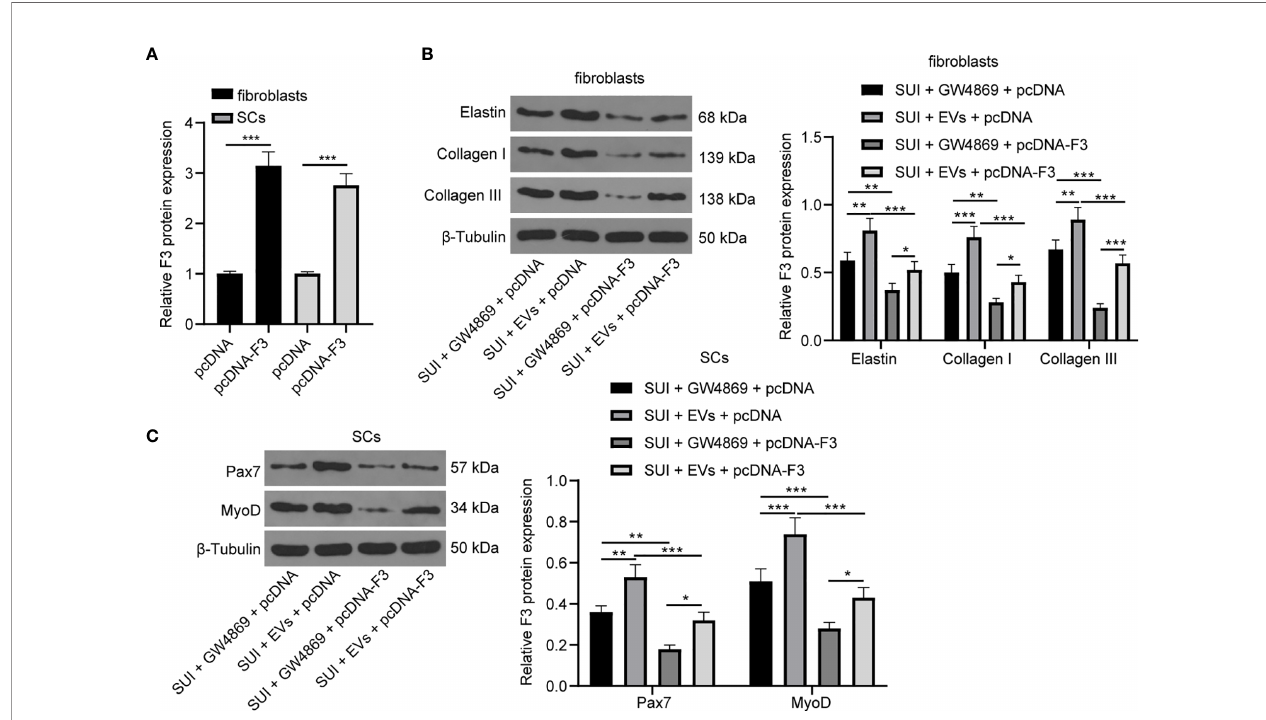
FIGURE 6 | ADSCs-EVs reverse the effect of F3 on SUI fi broblasts and SCs. (A) RT-qPCR detection of the transfection ef fi ciency of F3. (B) Western blot assay was utilized to detect the expression levels of Elastin, Collagen I, and Collagen III in SUI fi broblasts in each treatment group. (C) Western blot assay was utilized to detect the expression levels of Pax7 and MyoD in SUI SCs in each treatment group. GAPDH was used as the mRNA reference gene in the RT-qPCR data, and 2 − DD Ct was used for quantitative analysis; the Western blot assay data was normalized to the background value and the control b -Tubulin band value. N = 3. The differences between two groups were analyzed by Student ’ s t − test (A) . The differences among multiple groups were analyzed using one-way ANOVA and Tukey ’ s post hoc test (B, C) . * P < 0.05; ** P < 0.01; *** P <